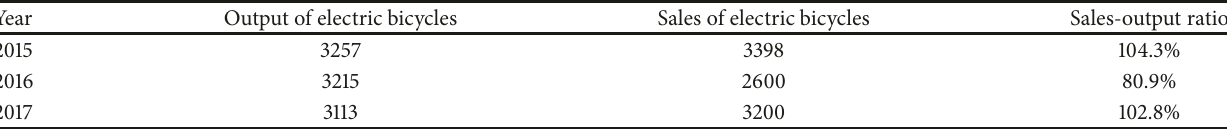
Table 2: Sales-output ratio of electric bicycles in 2015-2017 (unit: 10,000 sets.).